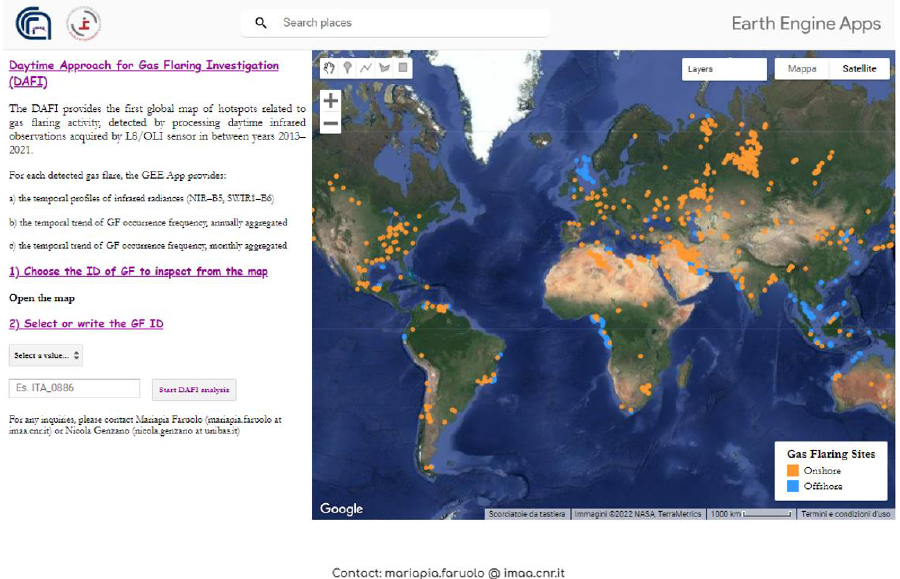
Figure 7. DAFI GEE App picture.